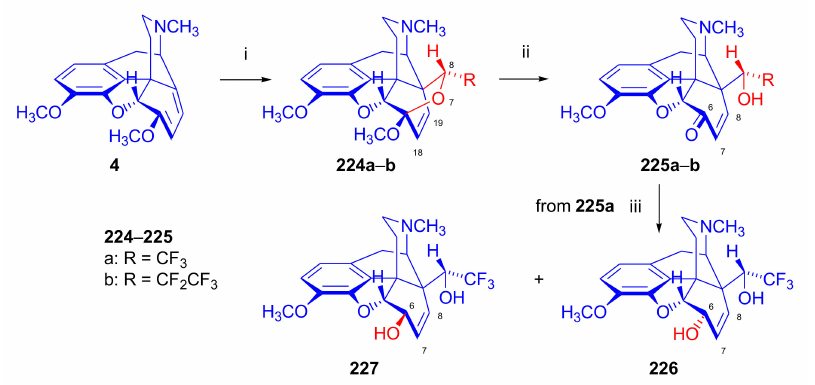
Figure 61. Reaction of thebaine with α -fluorinated aldehydes. Reagents and conditions : (i): 2,2,2- trifluoroacetaldehyde or 2,2,3,3-pentafluoropropanal, benzene, sealed tube, 50 ◦ C, 24 h; (ii): cc. HCl, THF (1:10), 25 ◦ C, 7 h; and (iii): NaBH 4 /CeCl 3 , methanol, 25 ◦ C.